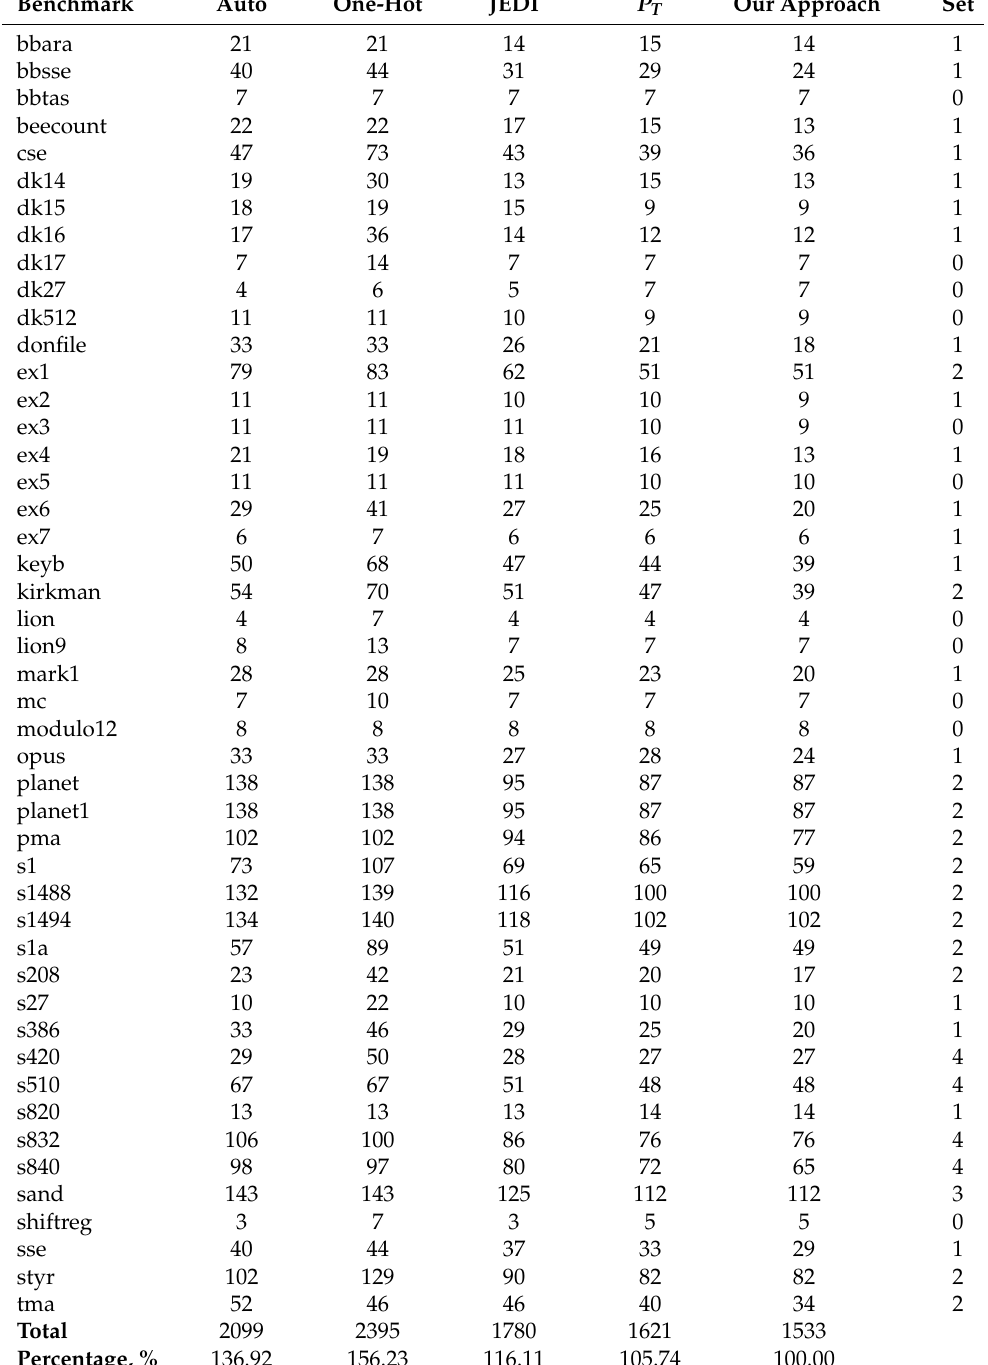
Table 9. Experimental results (the LUT